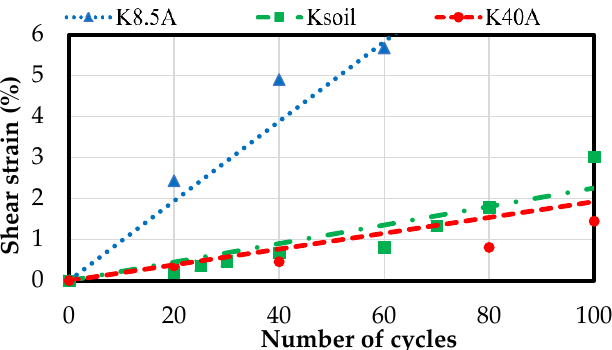
Figure 22. The earthquake-induced shear strain of embankments subjected to rainfall.